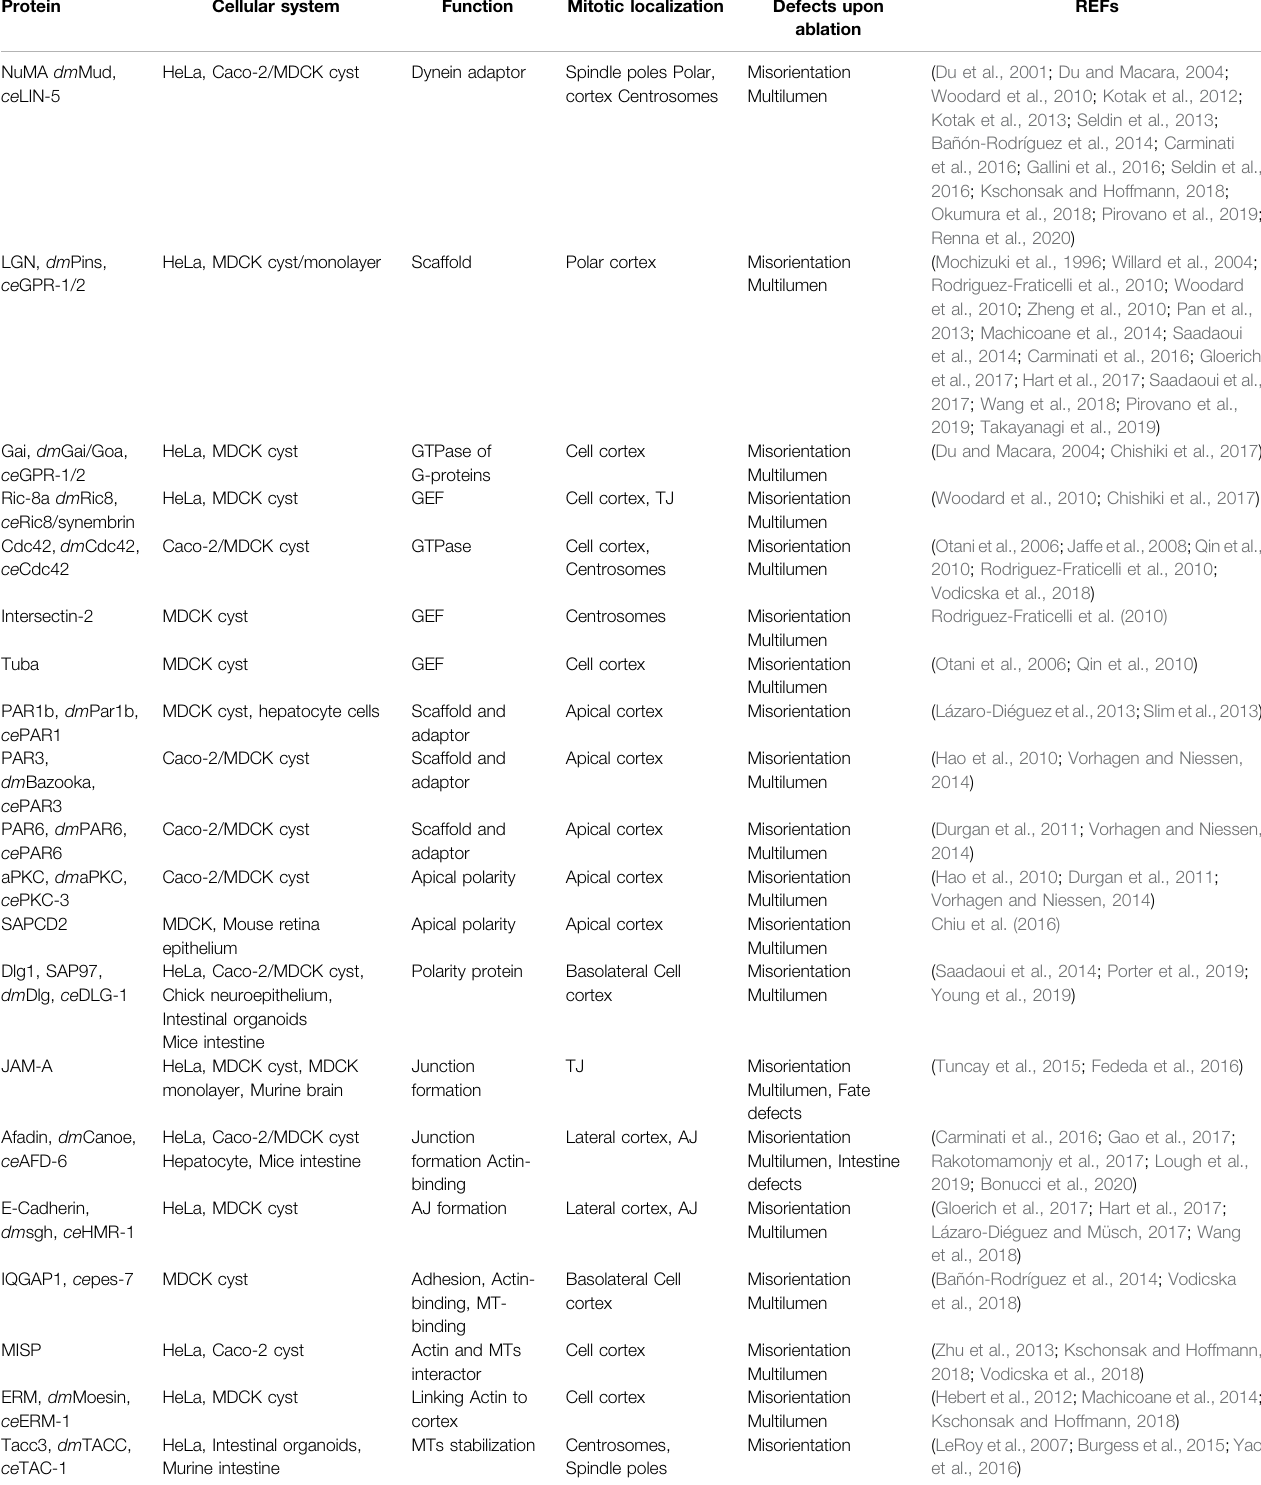
TABLE 1 | Proteins involved in division orientation, and model systems in which they were studied ( fl y and worm orthologues are reported, when